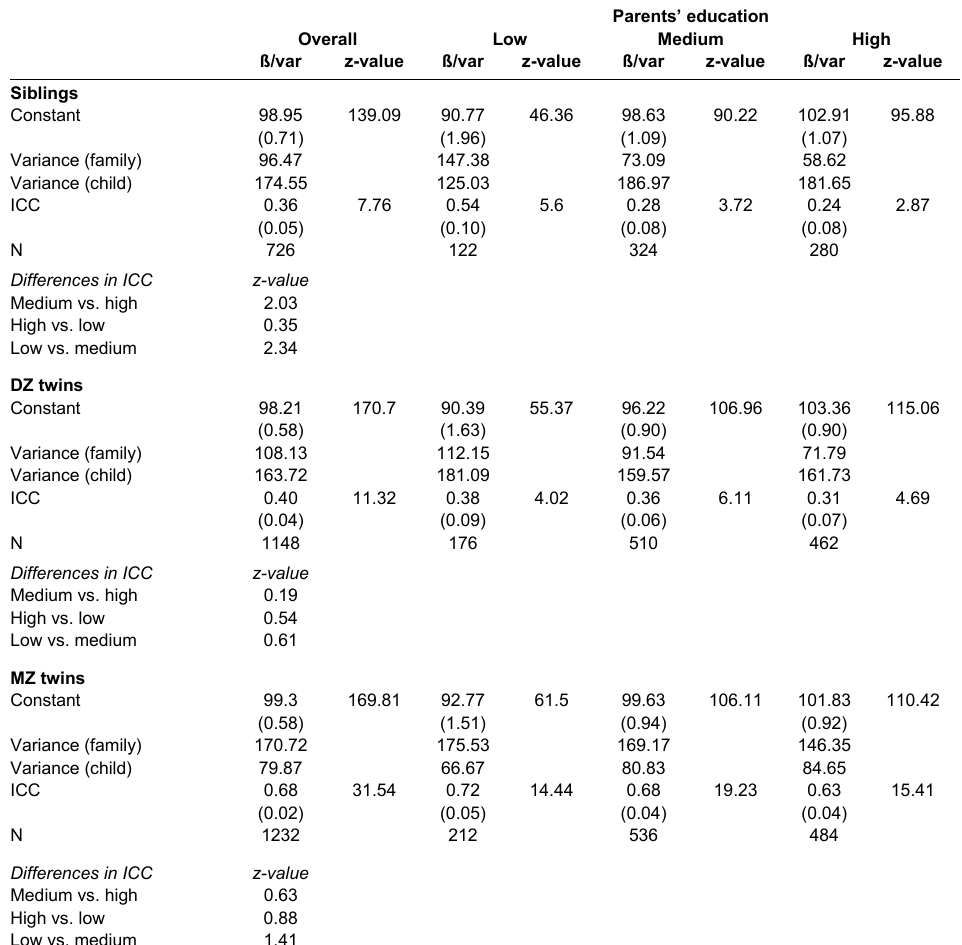
Table 3 : Sibling and twin similarity in cognitive ability according to parents’ education Parents’ education Overall Low z-value ß/var ß/var ß/var Siblings